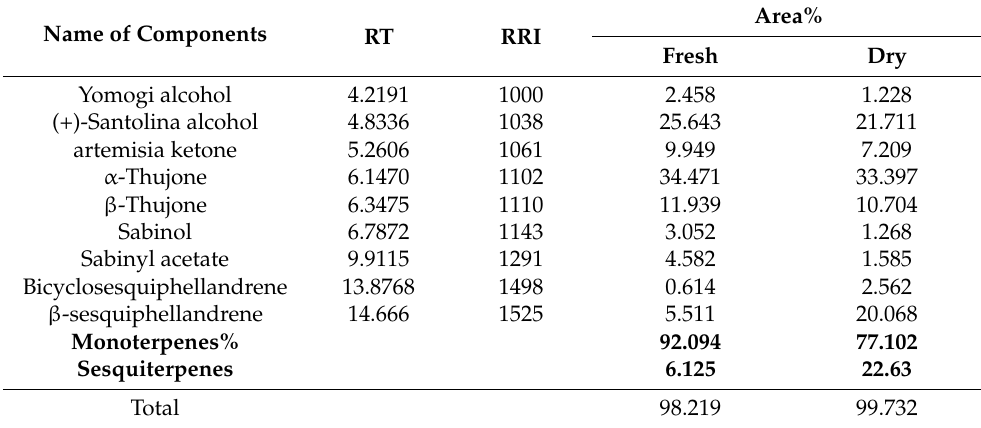
Table 2. Components of fresh and dried plant samples AFO.